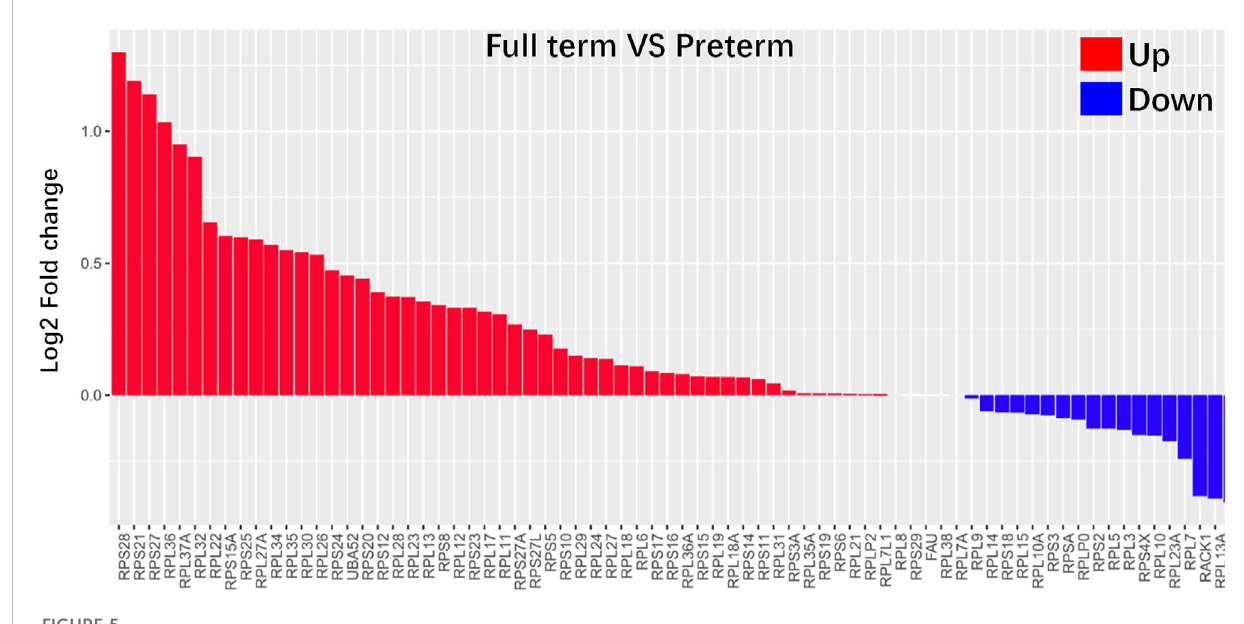
FIGURE 5 Ribosome-related genes were highly enriched in PDs from full-term rats (postnatal day 0). All 84 ribosome-related genes are listed in the Supplemental Table S2. Differences in all 84 ribosome-related genes between PDs from full-term and preterm rats were explored. The results showed that 73 of 84 ribosome-related genes were differentially expressed in PDs between preterm and full-term rats. The differences in these genes are represented as log2-fold changes. Fifty-one of 73 (approximately 70%) ribosome-related genes were enriched in PDs from full-term